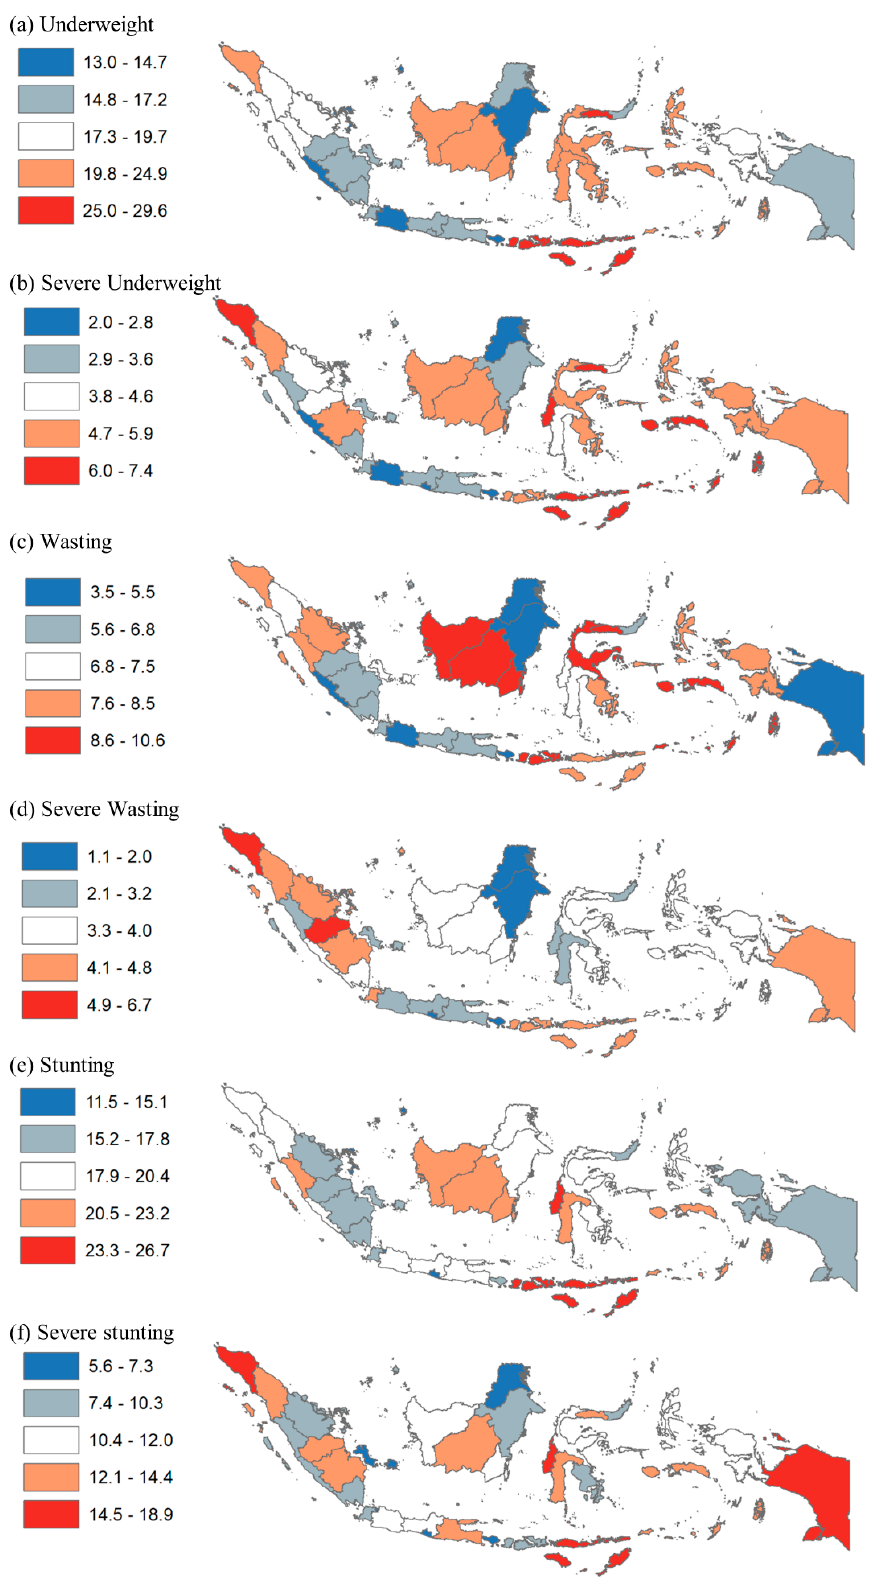
Figure 2. Disparity of Child Undernutrition by Province in Indonesia, 2018. Note: Values show prevalence of child